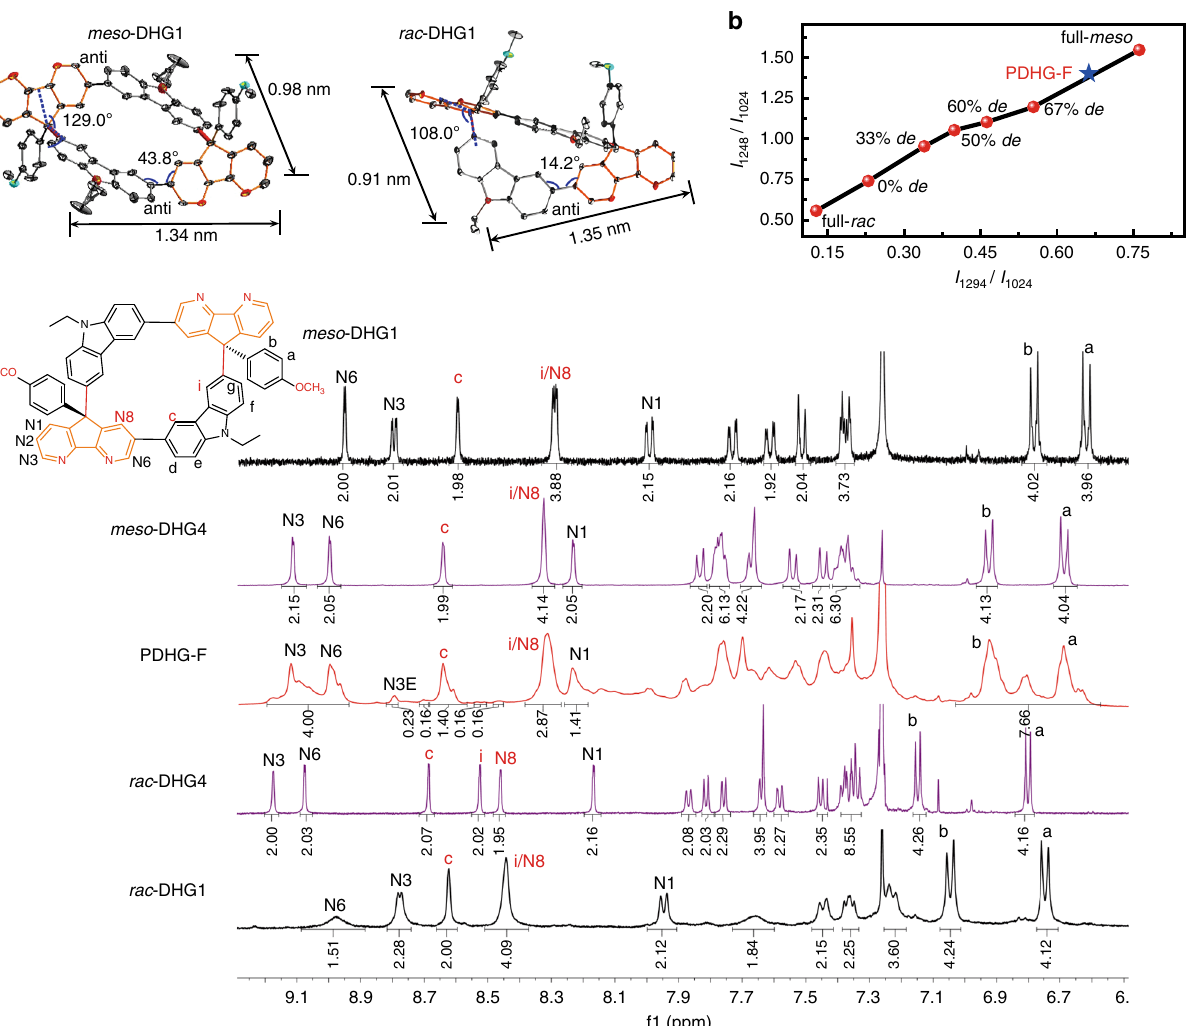
Fig. 3 Characterizations of the tacticity of DHGs and PDHG-F backbones. a The single-crystal crystallography of meso -DHG1 and rac -DHG1s. The blue lines exhibit the dihedral angles of the backbones. b The integral ratio of the vibrational absorption at 1248 ∼ 1264 cm − 1 band to 1024 cm − 1 band ( I 1248 / − 1 band to 1024 cm − 1 band ( I I I fi c mixing systems ( meso -DHG1 and rac -DHG1). These 1024 ) and the intensity ratio of the 1294 cm 1294 / 1024 ) for the speci results are extracted from the Fourier transform infrared spectra of mixing samples with well-de fi ned doping percentage (transformed to de value of meso - selectivity). For example, 0 % de = 1 : 1 of meso -DHG1 : rac -DHG1; full- rac represents the pure rac -DHG1 sample; full- meso represents the pure meso - DHG1 sample. The red dots exhibit the band intensity ratio of DHG1 mixing systems; the blue star shows the band intensity ratio of PDHG-F. c The 1 H NMR spectra of DHG1 (in black lines, as the end-capping units), DHG4 (in purple lines, as the repeat units), and PDHG-F (in red lines). The assignments of meso - DHG4 were made in reference to the 1 H – 1 H correlation spectroscopy results. The key positions associated with the stereoselective calculation (such as c, i, and N8 sites) are marked in